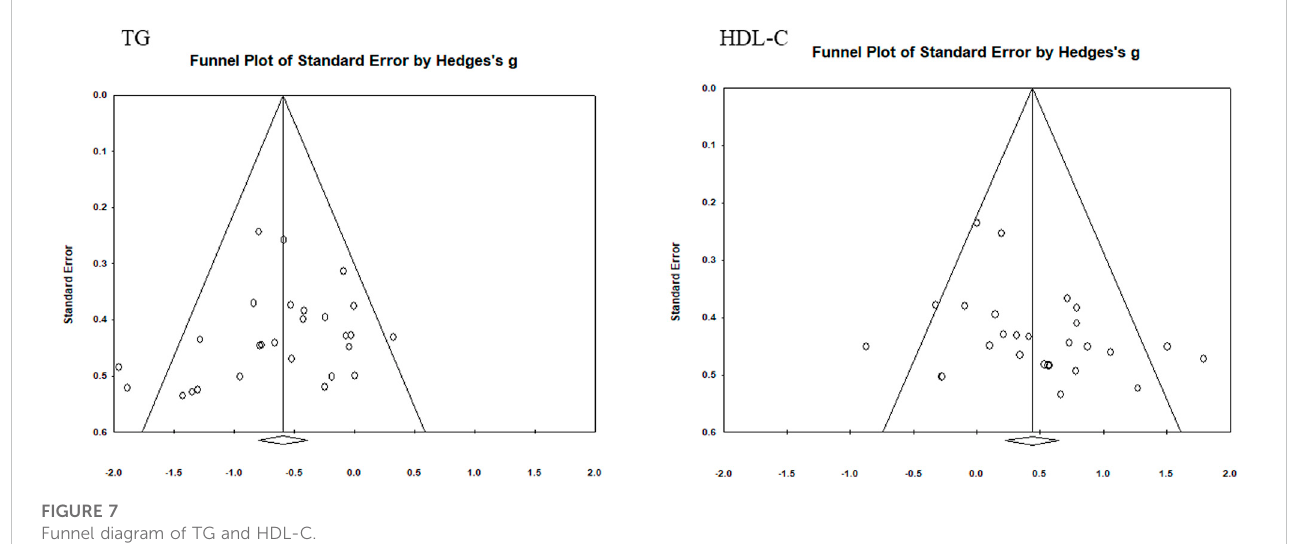
FIGURE 7 Funnel diagram of TG and